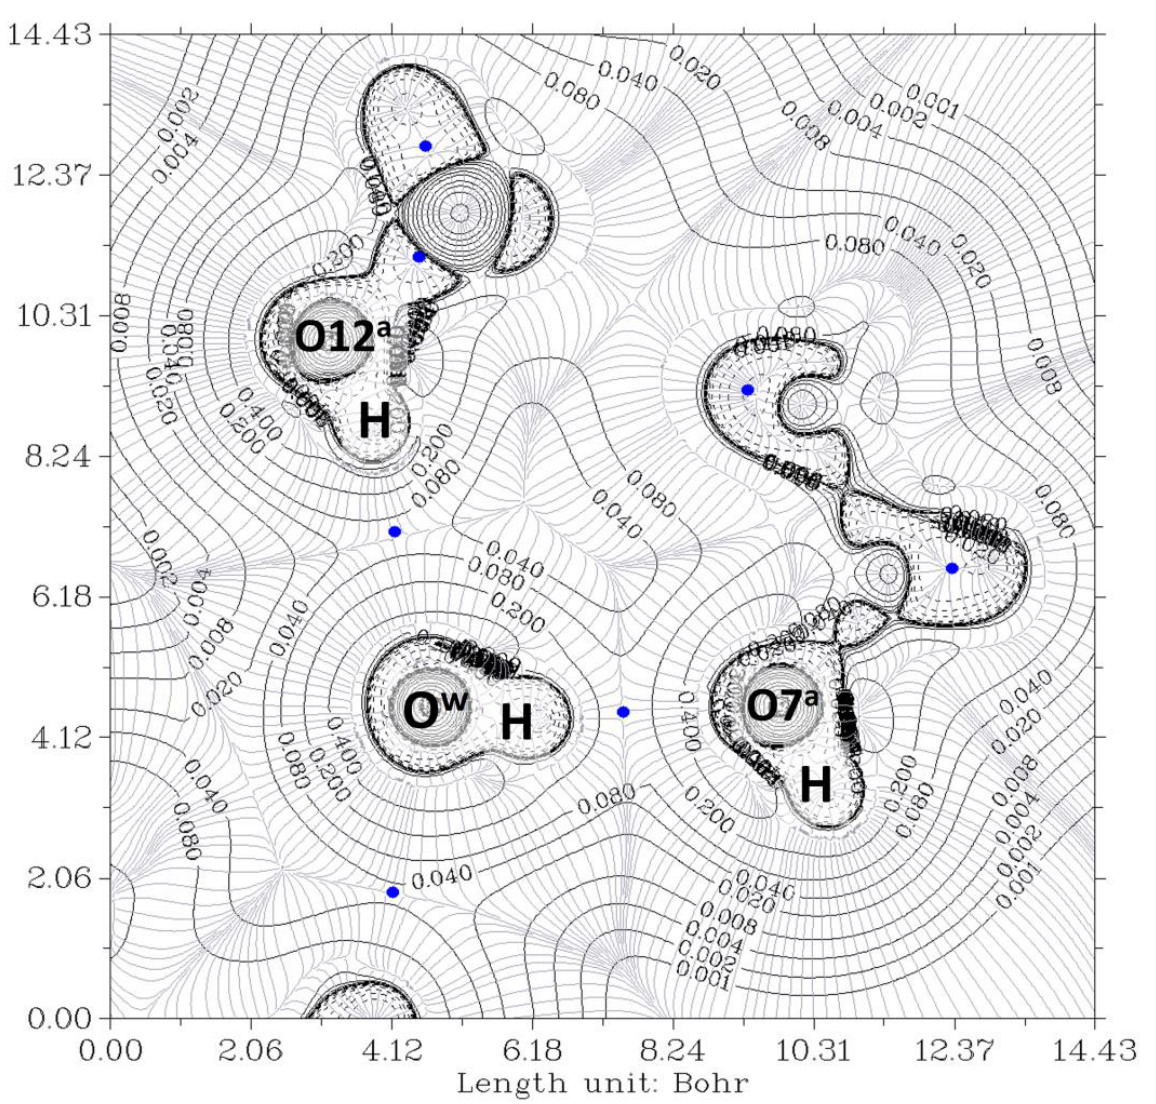
Figure 6. The electron density contour of the O 12a -H … O w -H ... O 7a complex (thin black lines) and BCP (3,-1) (blue dots). O 12a , O 7a , and O w are oxygen atoms from the pseudo-bile acid residues and water, respectively. Thin gray lines correspond to the gradient of the electron density. Figures 6 and 7 show the contour lines at the planes defined by O 7a -O w -O 12a and O 7b -O w -O 12b , respectively. In both cases, O w and O 12 exhibit peanut profiles directed towards the associated acceptor atoms O 7 and O w , respectively. In all cases, the bond paths of the four hydrogen bonds link the expected two atoms, and the HBCP is indicated with a blue color point. The analysis of the data was carried out as previously. The HBCPs are identified by numbers (Figure not shown), and, for association purposes, the HBCPs of the full complex are shown in brackets. Table 2 shows the obtained